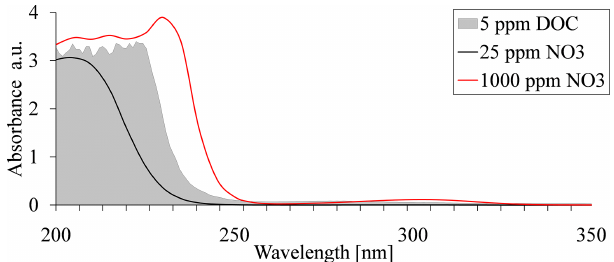
Figure 1. Absorption spectra of nitrate at concentrations of 25, 1000, and 5ppm dissolved organic carbon